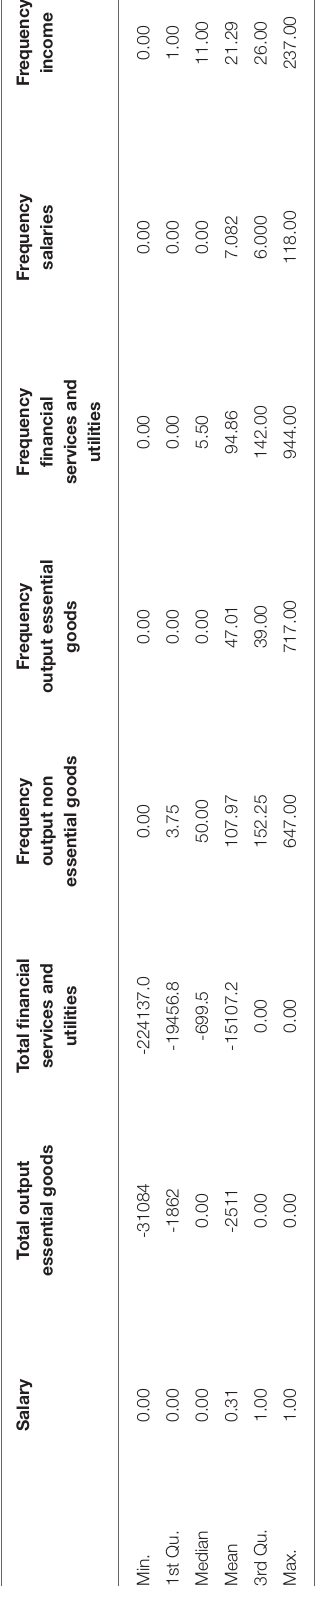
TABLE 3 | Important variables selected by Lasso Model on financial dataset.